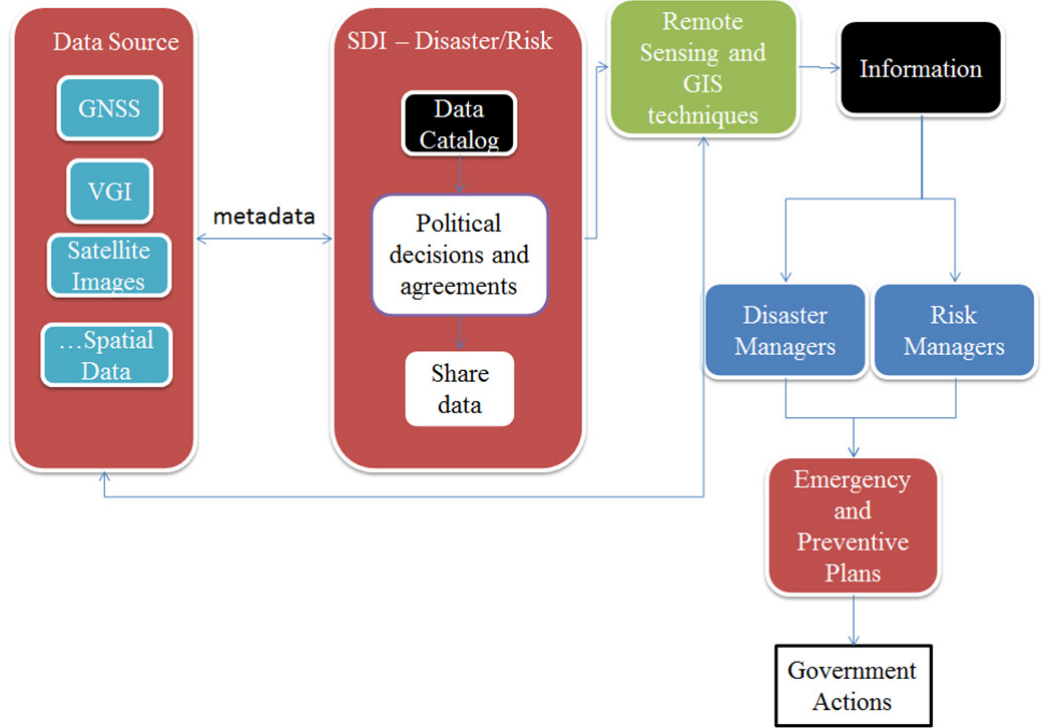
Figure 1. Scheme for space-based data use for risk and natural disaster